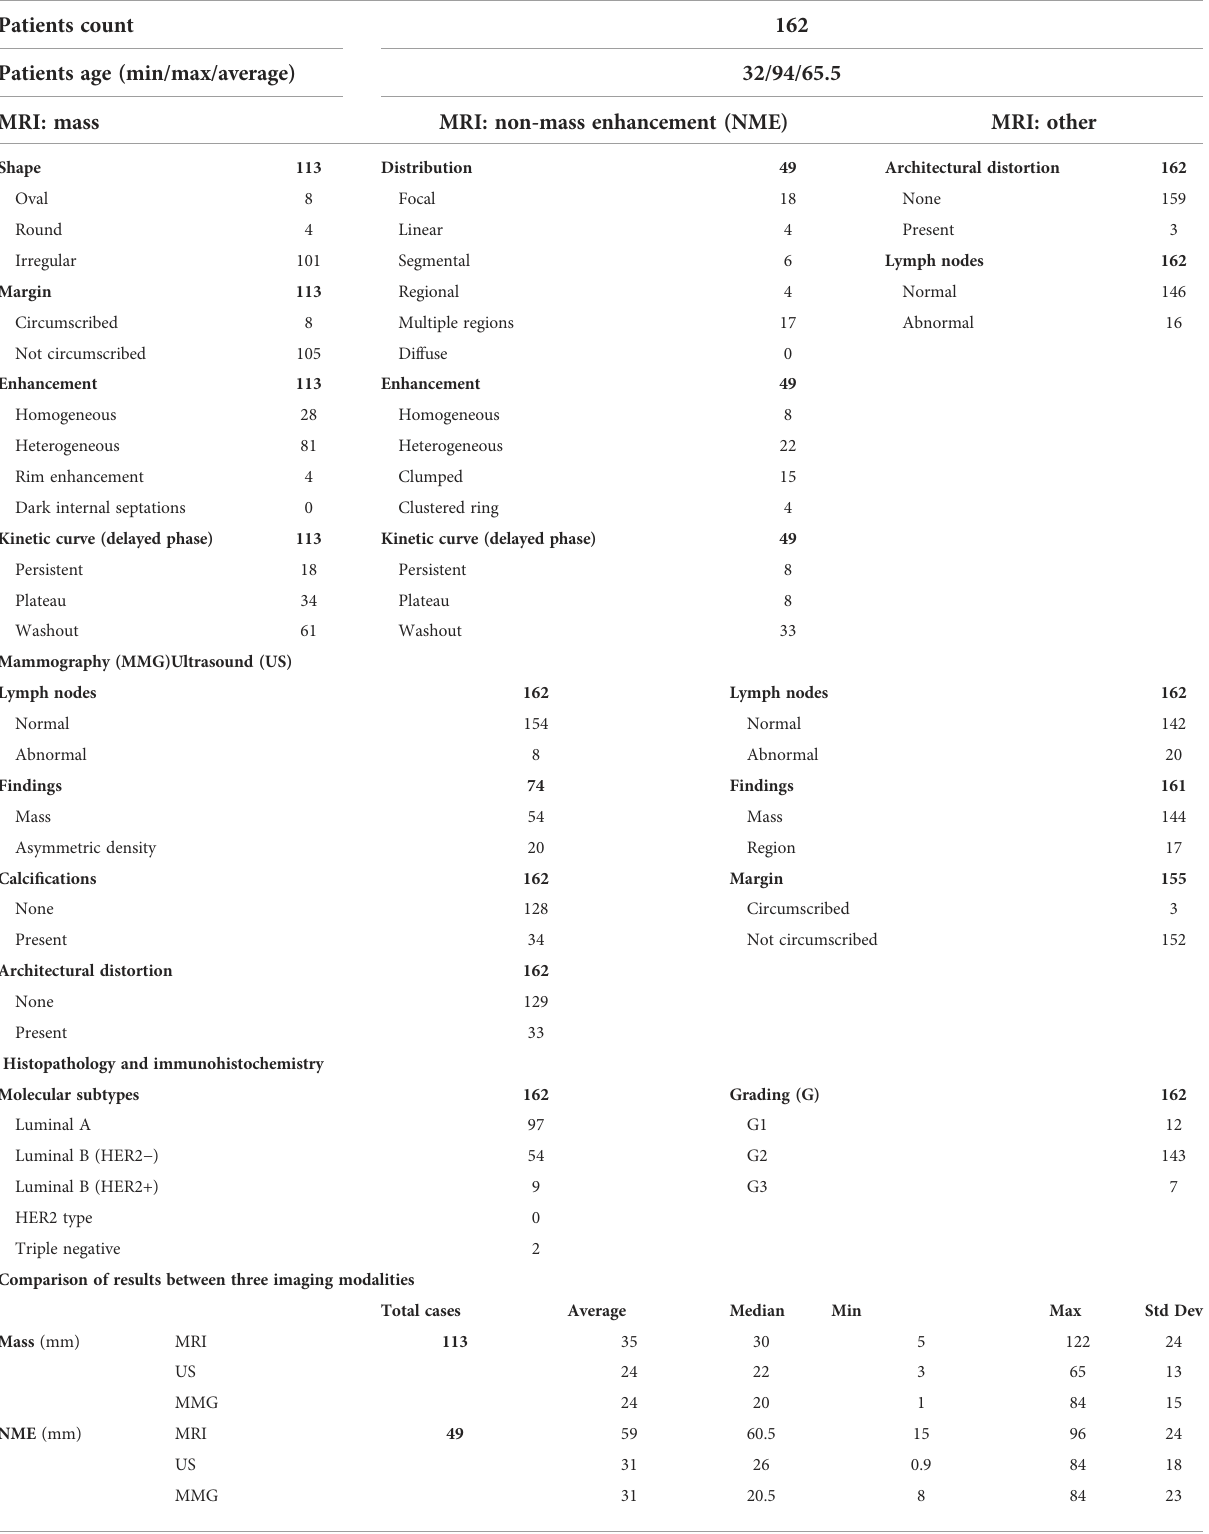
TABLE 1 Imaging parameters and clinicopathological features of 162 patients with invasive lobular